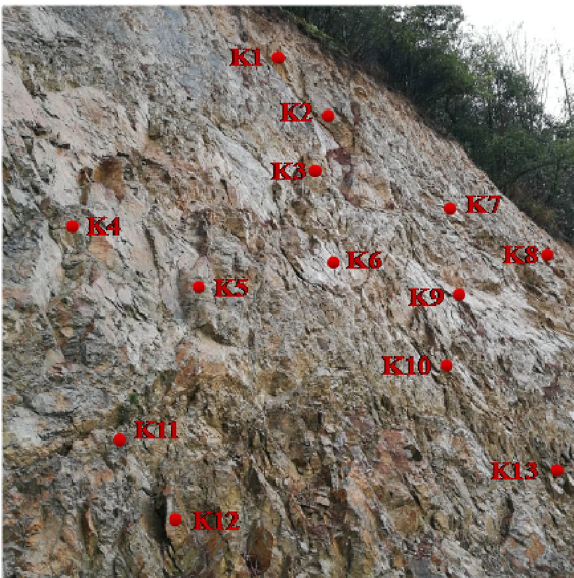
Figure 12. Typical blocks parallel to rock slope surface.